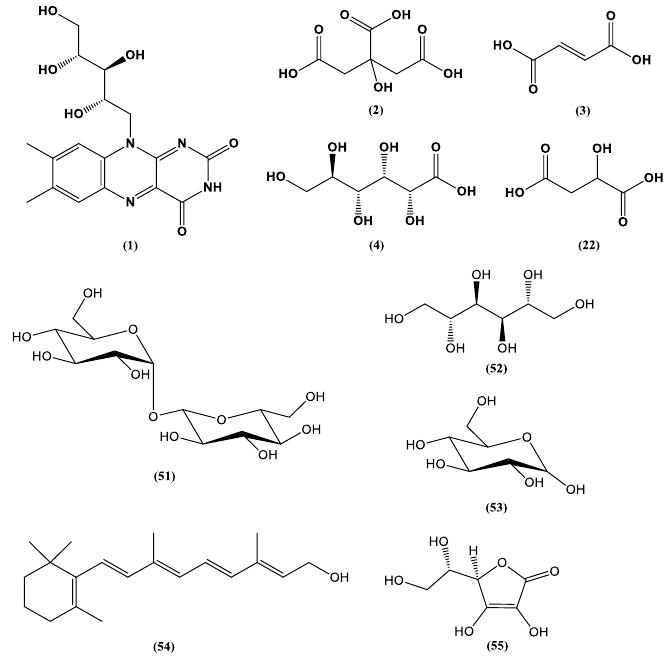
Figure 1. Chemical structures of some fungal-derived food additives (1–4, 22, 51–55) .